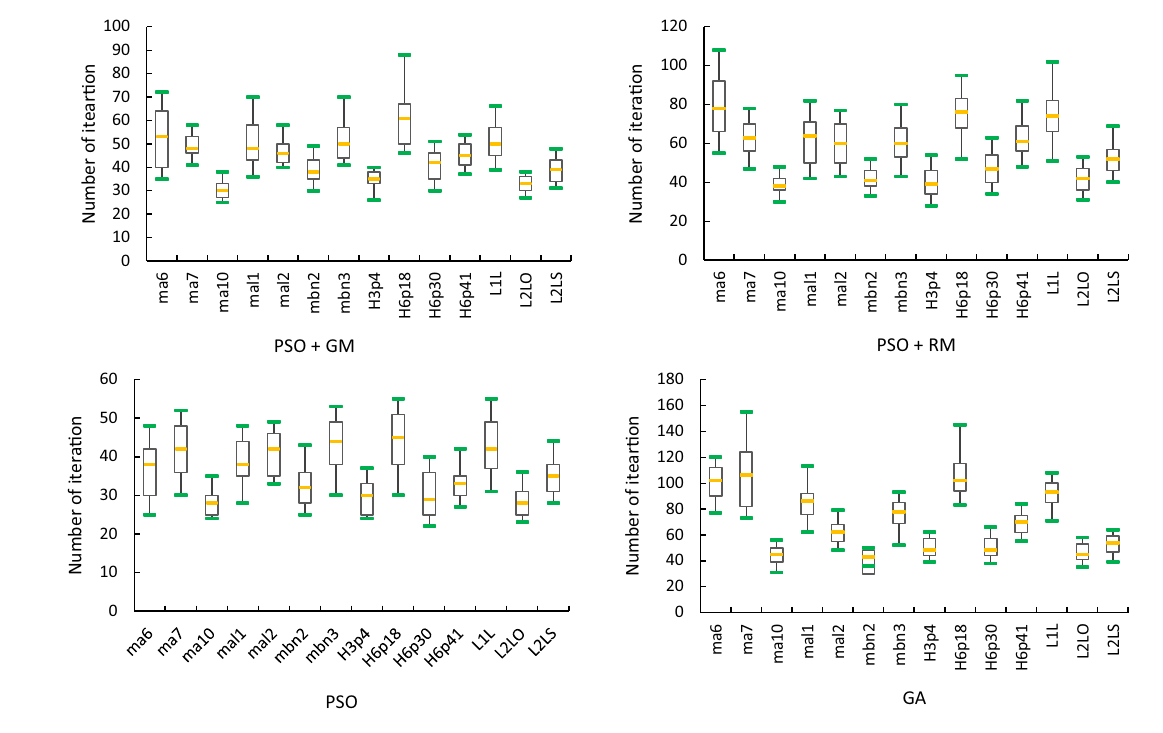
Fig. 6 Number of generation of four different